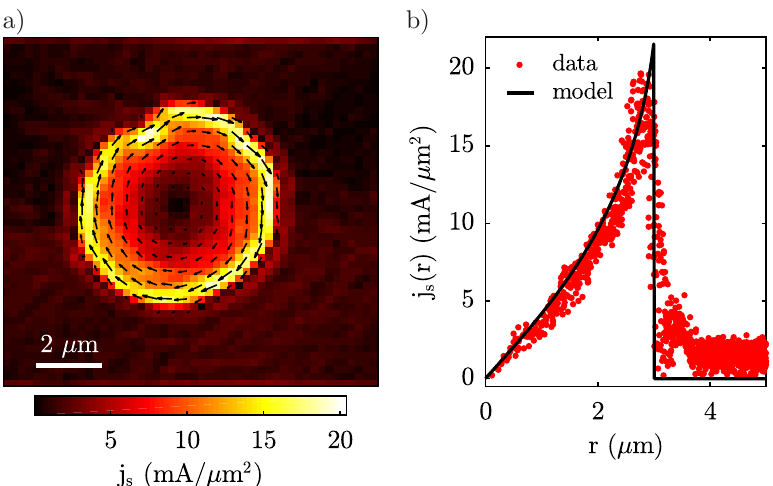
Figure 4. ( a ) Current density j s reconstructed by magnetic field reverse-propagation from the data in Figure 2a. The circular currents generate a magnetic field counteracting the external magnetic field. ( b ) Azimuthal average of the current density j s ( r ) as a function of distance to the disk centre, along with the current density calculated in the numerical